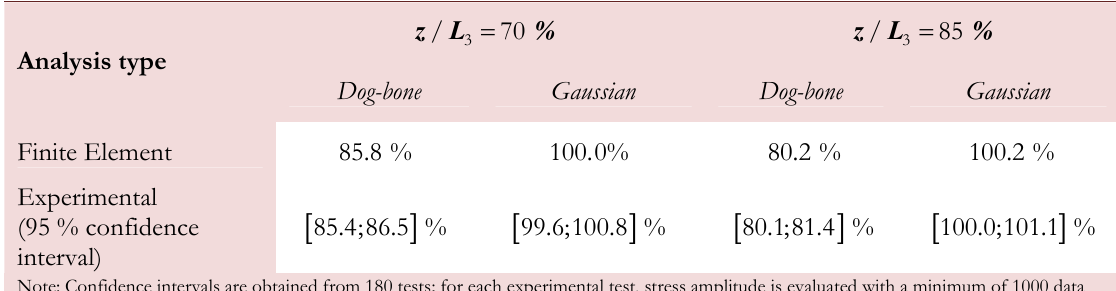
σ / σ percent center